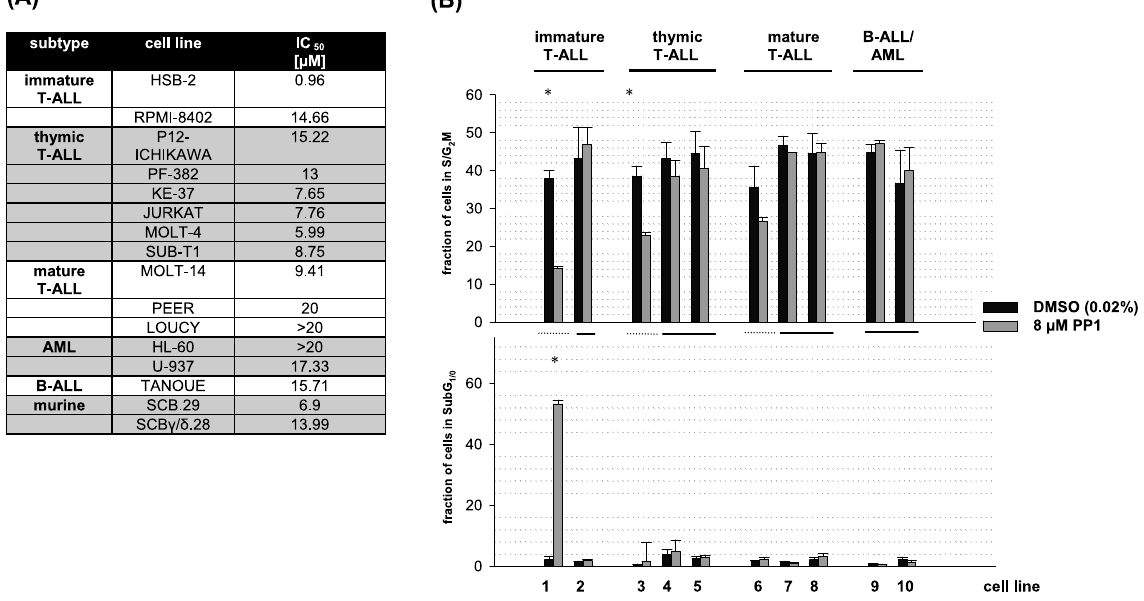
Fig. 3. Functional analysis in transgenic cell lines and T-ALL cell lines. (A) IC 50 values in human cell lines (T-ALL and non-T-ALL) after PP1 exposure; mean IC 50 value of 5 experiments is shown – each experiment was performed as triplicate. (B) Cell cycle analysis of PP1 sensitive ( < 10 µM PP1; dotted line) and non-sensitive cell lines (continuous line), previously defined by IC 50 determination. Results for PP1 treated cell lines and controls (0.02% DMSO) are shown; average of 2 experiments is shown – each experiment was performed as triplicate. ( ∗ ) p (cid:2) 0 . 01 for PP1 (8 µM) treated cells compared to control. (1) HSB-2, (2) RPMI-8402, (3) MOLT-4, (4) P12-ICHIKAWA, (5) PF-382, (6) MOLT-14, (7) LOUCY, (8) PEER, (9) TANOUE, (10)